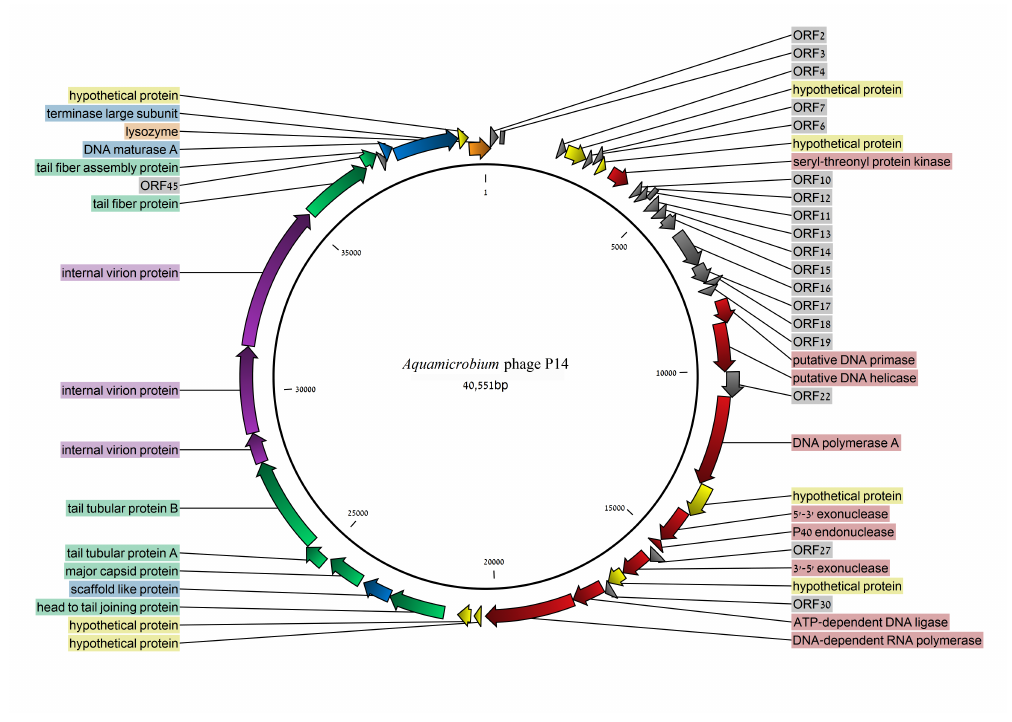
Figure 2. The genome of the Aquamicrobium phage P14. Open reading frames (ORFs) with blastx hits [29] are indicated in color. Yellow : hypothetical proteins; orange : lysozyme; blue : phage packaging (assembly); purple : internal virion proteins; green : structure proteins; and red : all other